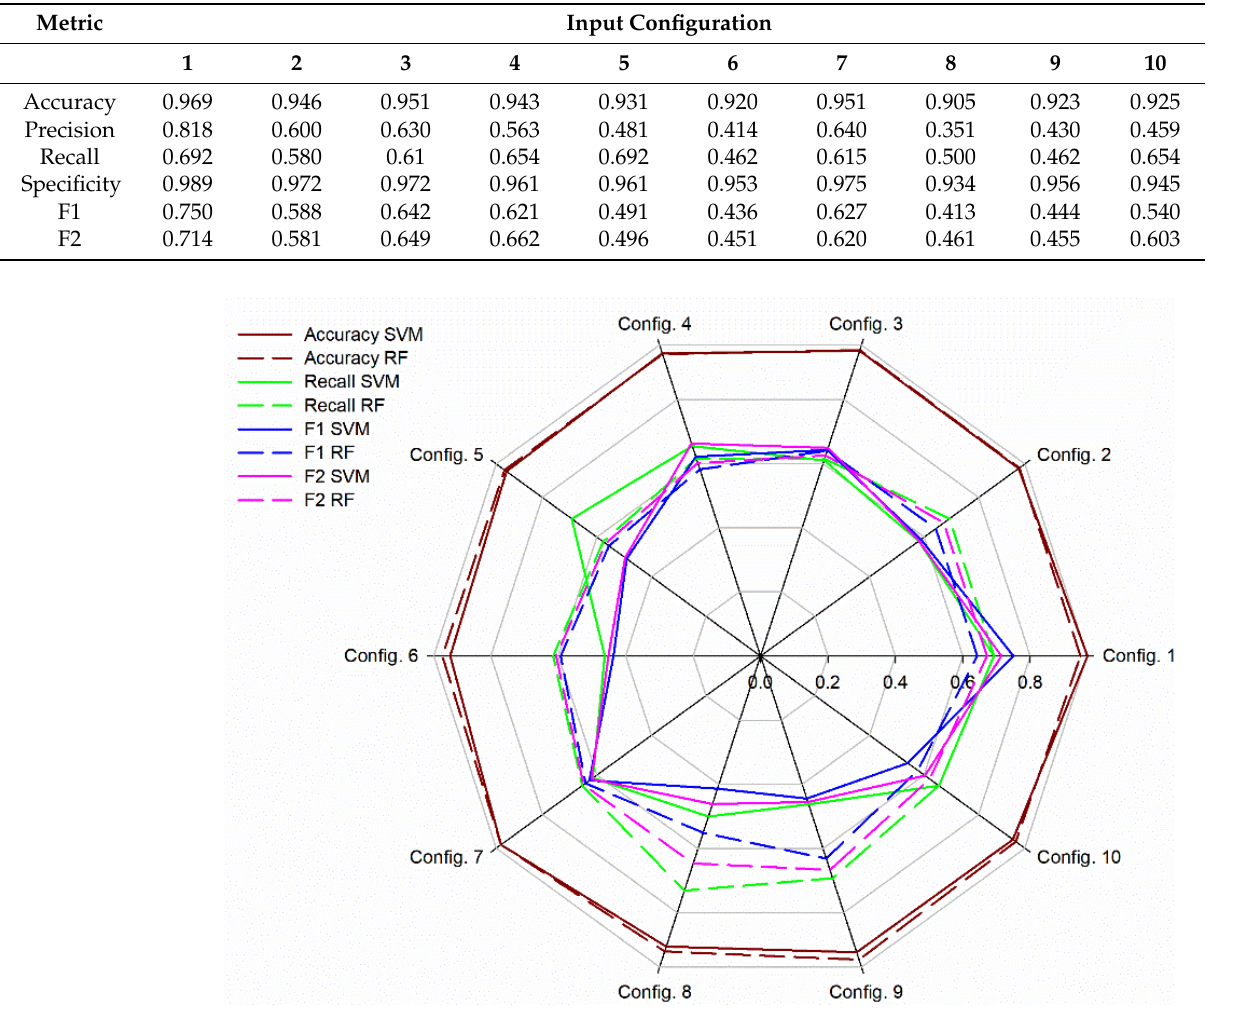
Table 6. SVM model performance metrics with the MWMOTE ‐ balanced dataset.